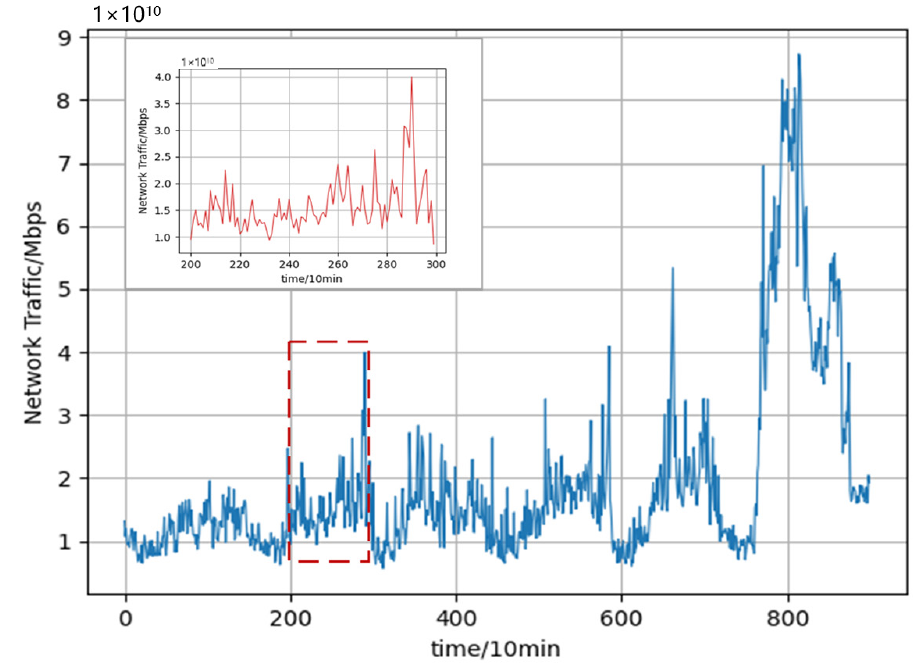
Figure 1. Self-similarity of network traffic.